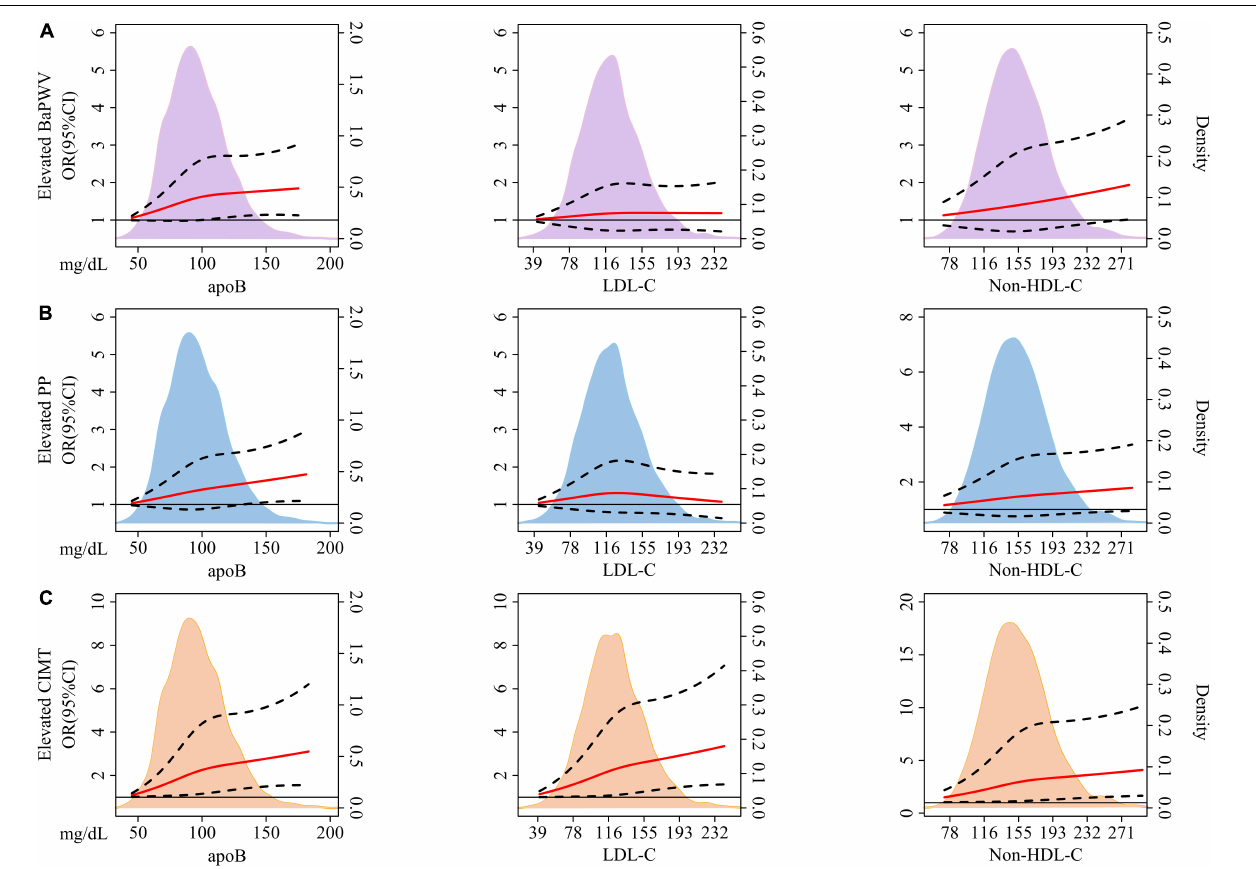
FIGURE 2 | The association between baseline concentration of each lipid variable and incident elevated baPWV (A) , PP (B) , and CIMT (C) based on restricted cubic splines. The solid red lines represent a fitted relationship and dashed lines show 95% confidence intervals. Reference line for no association (Odds ratio: 1.0) is indicated by solid black line while areas of purple , blue , and orange represent the density distribution of lipid traits with incident elevated baPWV (A) , PP (B) , and CIMT (C) as ending points, respectively. Model was adjusted for baseline age, sex, BMI, smoking status, drinking status, physical activity, glucose-lowering therapy, and lipid-lowering therapy. ApoB, apolipoprotein B; LDL-C, low-density lipoprotein cholesterol; Non-HDL-C, non-high-density lipoprotein cholesterol; BaPWV, brachial-ankle pulse wave velocity; PP, pulse pressure; CIMT, carotid intima-media thickness; OR, odds ratio; CI, confidence interval; BMI, body mass index.